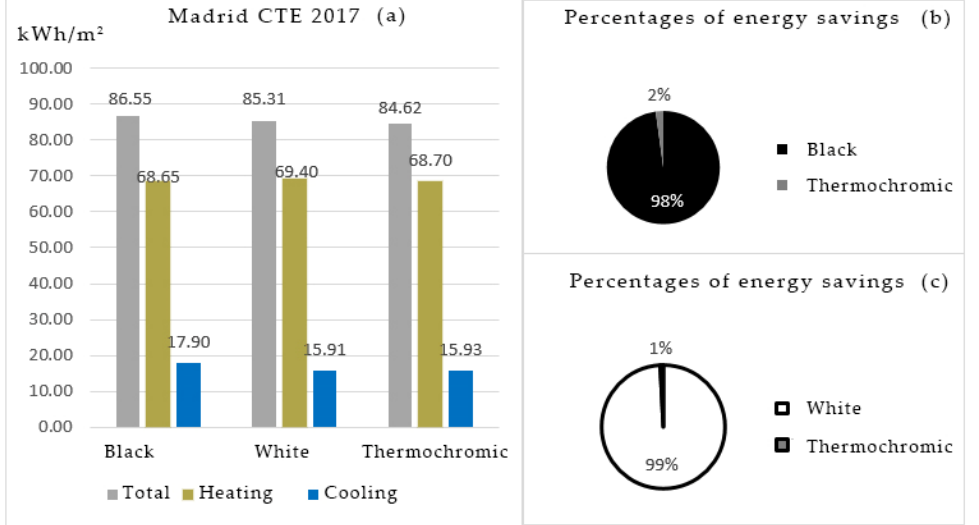
Figure 13. ( a ) Energy demand for heating and cooling in the case of Madrid CTE 2017. ( b ) Thermochromic vs. black surface finish energy savings. ( c ) Thermochromic vs. white surface finish energy savings.